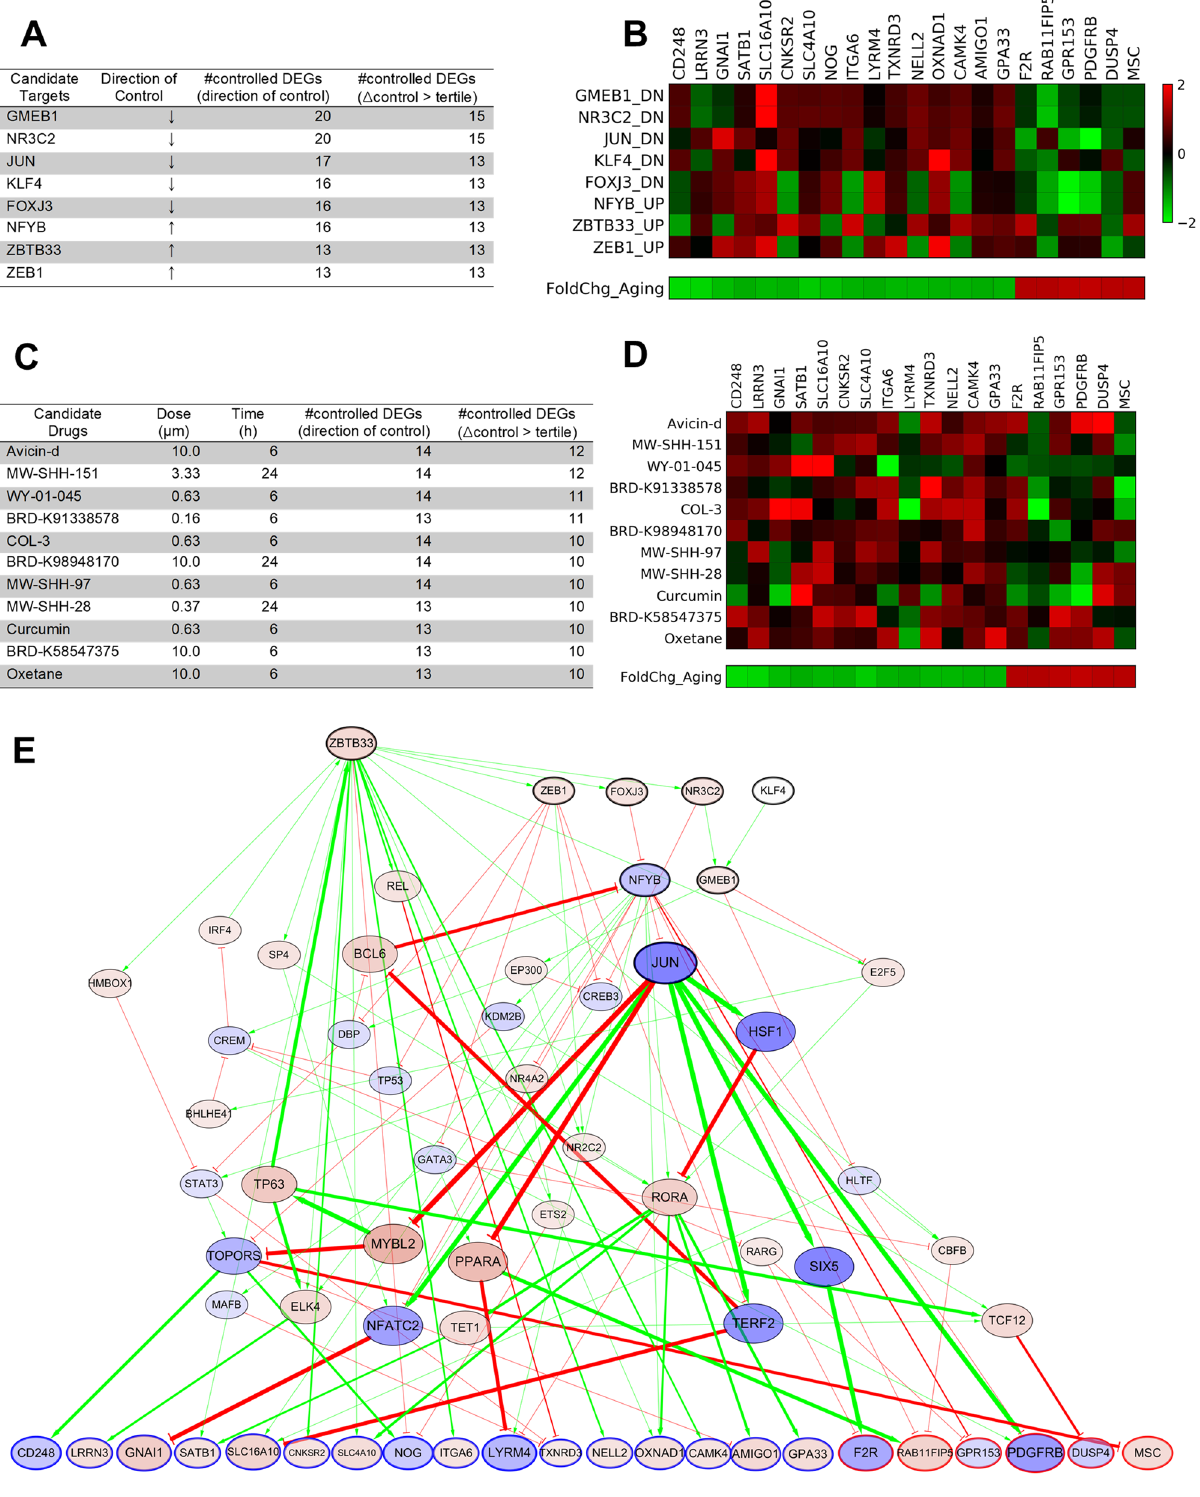
Figure 4. Candidate target genes identified by signal flow analysis and candidate drugs screened from the LINCS database. ( A ) List of candidate molecular targets predicted to reversely regulate the aging-related DEG expression. ( B ) Heatmap of the calculated DACs of the output DEGs for the candidate molecular target. ( C ) List of candidate drugs identified from the LINCS database that reversely regulate the DEG markers. ( D ) Heatmap of the observed expression changes of the output DEGs induced by candidate drugs. ( E ) Subnetwork visualization of candidate targets that reversely regulate the aging-related DEG expression, considering the initial signal that down-regulates JUN (blue). Signals from the candidate target genes (nodes with a black bold boundary) are transmitted via the network with up-regulating (red) or down-regulating (blue) downstream genes, and eventually regulate the aging-related expression of the output DEGs (the color of boundary denotes the expression fold change during